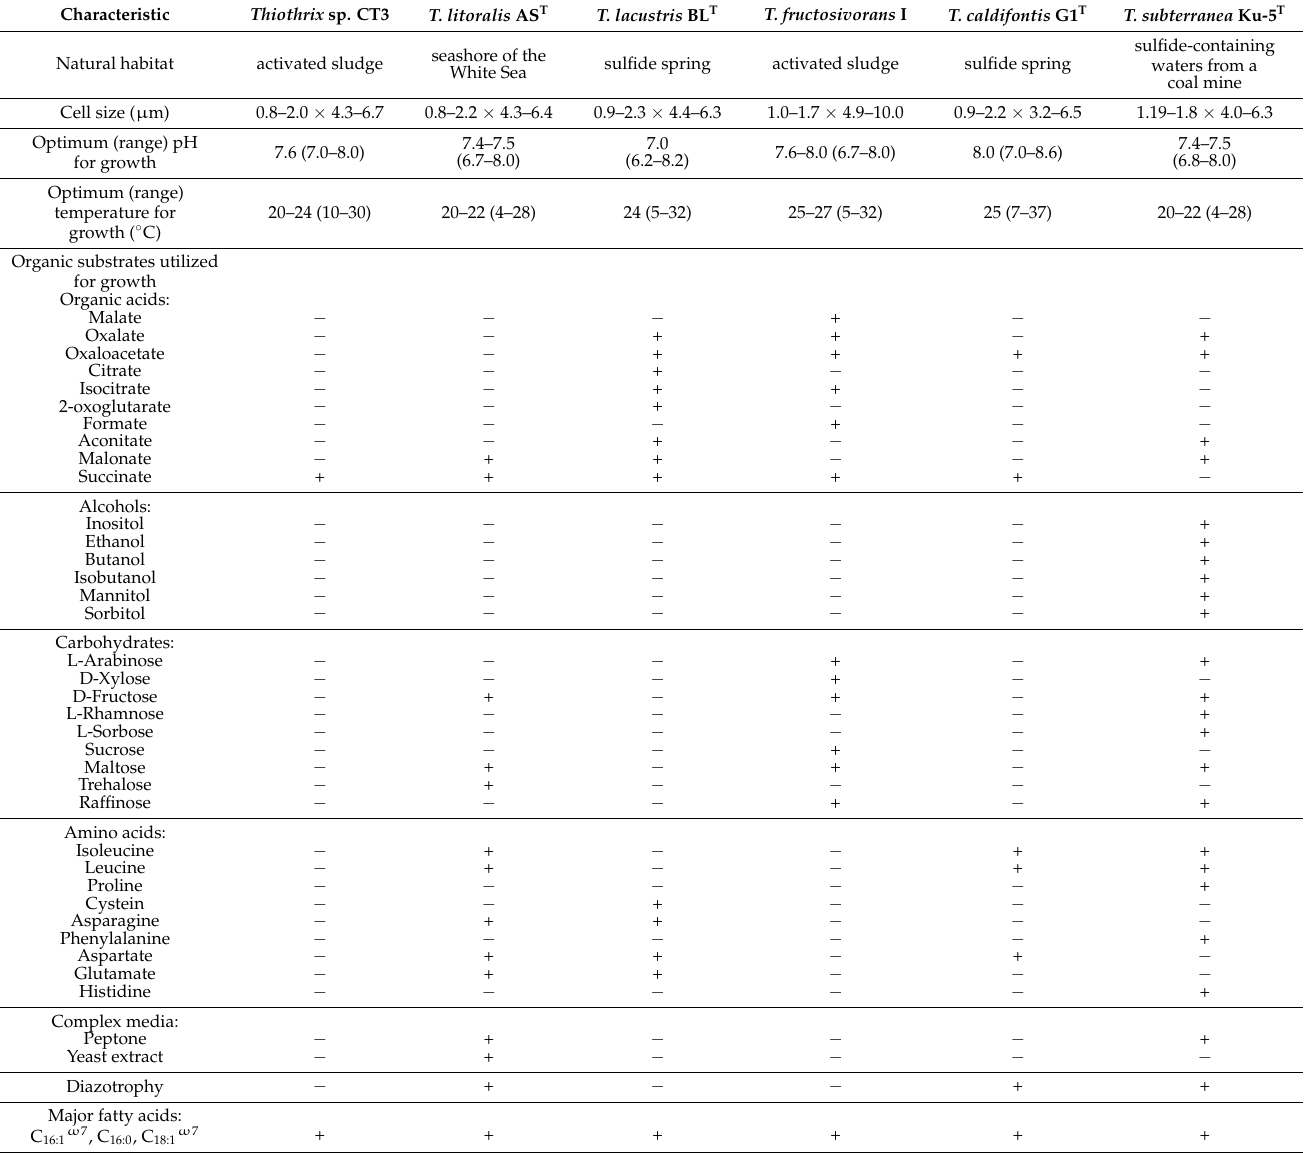
Table 1. Differentiating characteristics between phylogenetically related species from the genus Thiothrix (Clade I). All strains utilize acetate, lactate and pyruvate. Glyoxylate, glycolate, benzoate, salicylate, methanol, isopropanol (propan-2-ol), glycerol, lactose, D-galactose, D-(+)-glucose, D- mannose, serine, lysine, tryptophan, methionine, tyrosine, ornithine, glutamine and alanine do not support the growth of all strains. All strains are capable of chemolitoautotrophic growth with thiosulfate and bisulfide. All strains are capable of respiration of nitrate to nitrite. No strains hydrolyze gelatin or starch. All strains are catalase-negative. None of the strains grow at 3% NaCl. Thiothrix litoralis AS T is able to survive with up to 3% NaCl in the medium. The major fatty acids for all strains are C 16:1 ω 7 , C 16:0 , C 18:1 ω 7 . Data are from